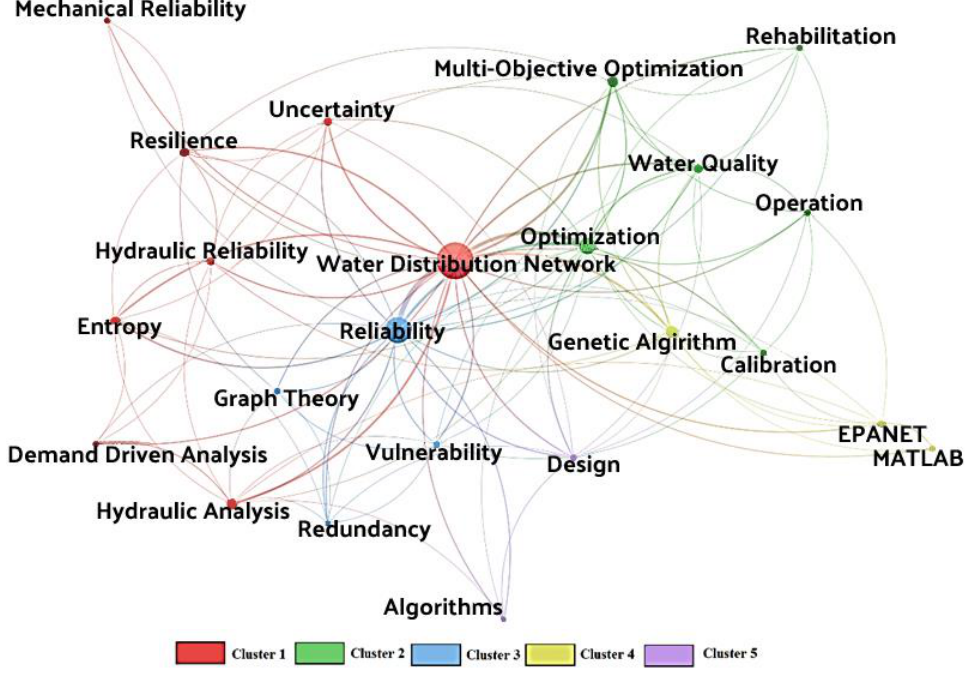
Figure 8. Clusters based on author keywords. Node size represents the number of occurrences of the keyword and the link between two nodes represent their simultaneous occurrences in